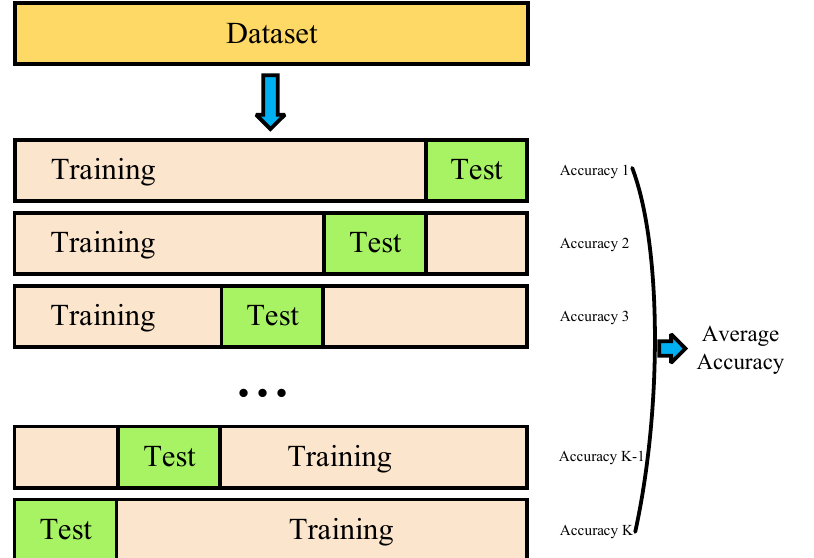
Figure 11. K ‐ fold cross ‐ validation principle.